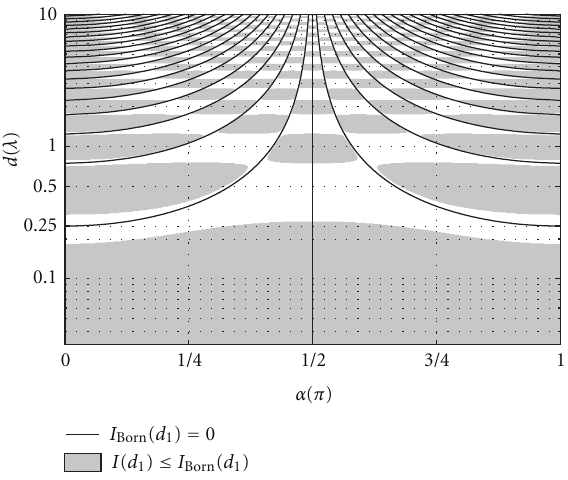
Figure 7: Map of the regions where multiple scattering e ff ects do not aid estimation of target location in relation to blind conditions of the Born approximation model. Black lines mark conditions where I Born ( d 1 ) = 0. Gray areas mark regions where I ( d 1 ) ≤ I Born ( d 1 ). The same parameters are used here as in Figure 6 ( τ 1 = τ 2 = 1, and β = π − α ).